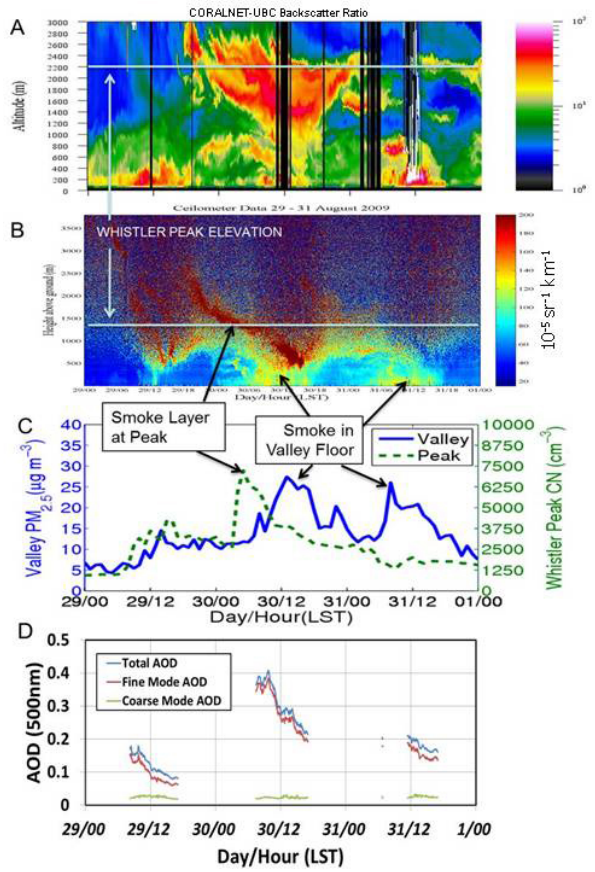
Fig. 5. (A) CORALNet-UBC 1064 nm backscatter ratio data from Vancouver – red and yellow hues show smoke layer (B) Whistler ceilometer two-way attenuated backscatter profile data – smoke layer depicted in red (C) Whistler Peak CN and Whistler Valley PM 2 . 5 observations and (D) Saturna Island AERONET AOD mea- surements at 500nm, divided into fine and coarse mode using Spec- tral Deconvolution Algorithm (SDA) for the period 29–31 August 2009. Note, because of the instrument elevation differences be- tween the ceilometer and lidar, Whistler Peak elevation (a.g.l.) dif- fers (marked by a horizontal line across each image in panels A and B